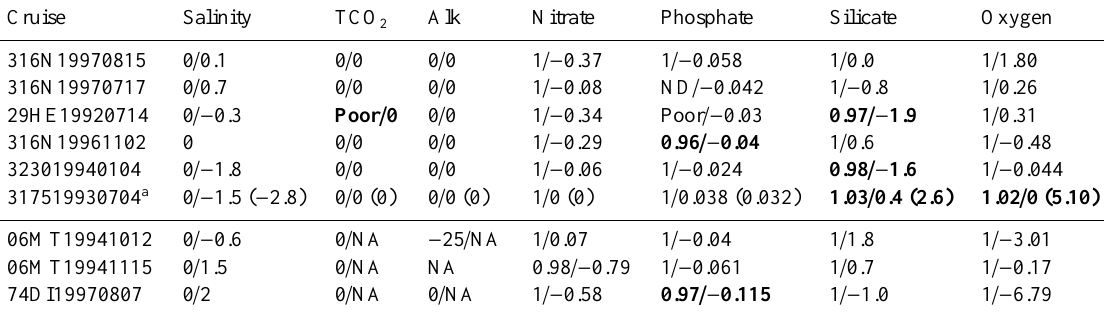
Table 3. Table with comparison of previously applied adjustments for the reference cruises in CARINA-ATL; the first numbers are the adjustments suggested by the CARINA team, the number after the slash are the adjustments applied to the GLODAP data base (Gouretski and Jancke, 2001; Sabine et al., 2005). The cruises above the bold line are reference cruises (i.e. are not part of CARINA), the three cruises below the line are cruises that are included both in CARINA and GLODAP. The salinity adjustments are in ppm, all other adjustments in µ mol / kg (when not a multiplicative factor). Note that all adjustments to the GLODAP data are additive whereas the nutrients and oxygen corrections for CARINA are multiplicative. All adjustments di ff erent from 0 (or 1 for multiplicative adjustments) for CARINA are printed in bold